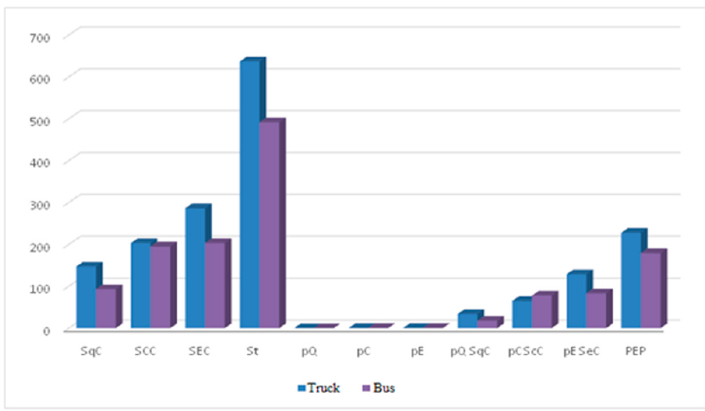
Figure 2. The synthetic indicators of the “Tractor Truck 18. 5 tons” and “ Urban Crosstown Bus”.